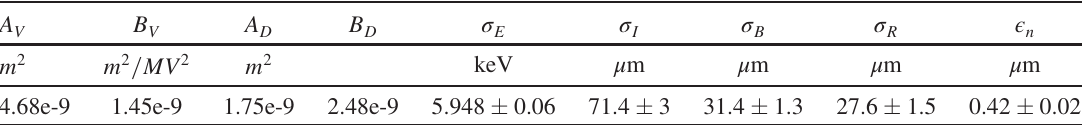
TABLE V. The reconstructed data from the measurements with the dispersion scan method.